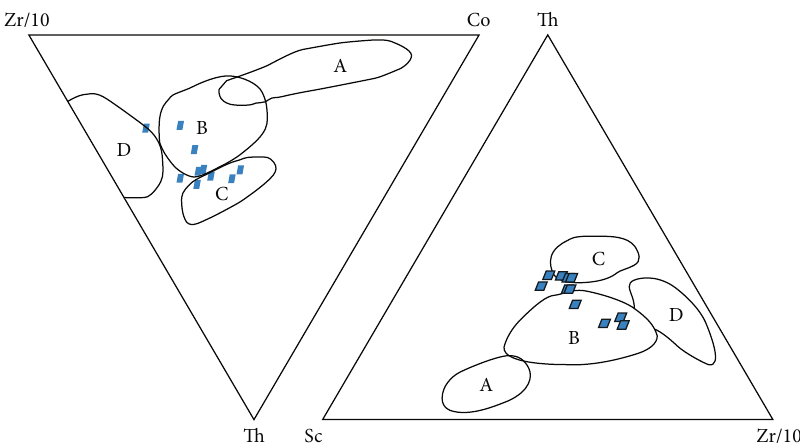
Figure 11: La-Th-Sc and Th-Sc-Zr/10 tectonic discrimination diagram [42]: A — oceanic island arc; B — continental island arc; C — active continental margin; D — passive continental